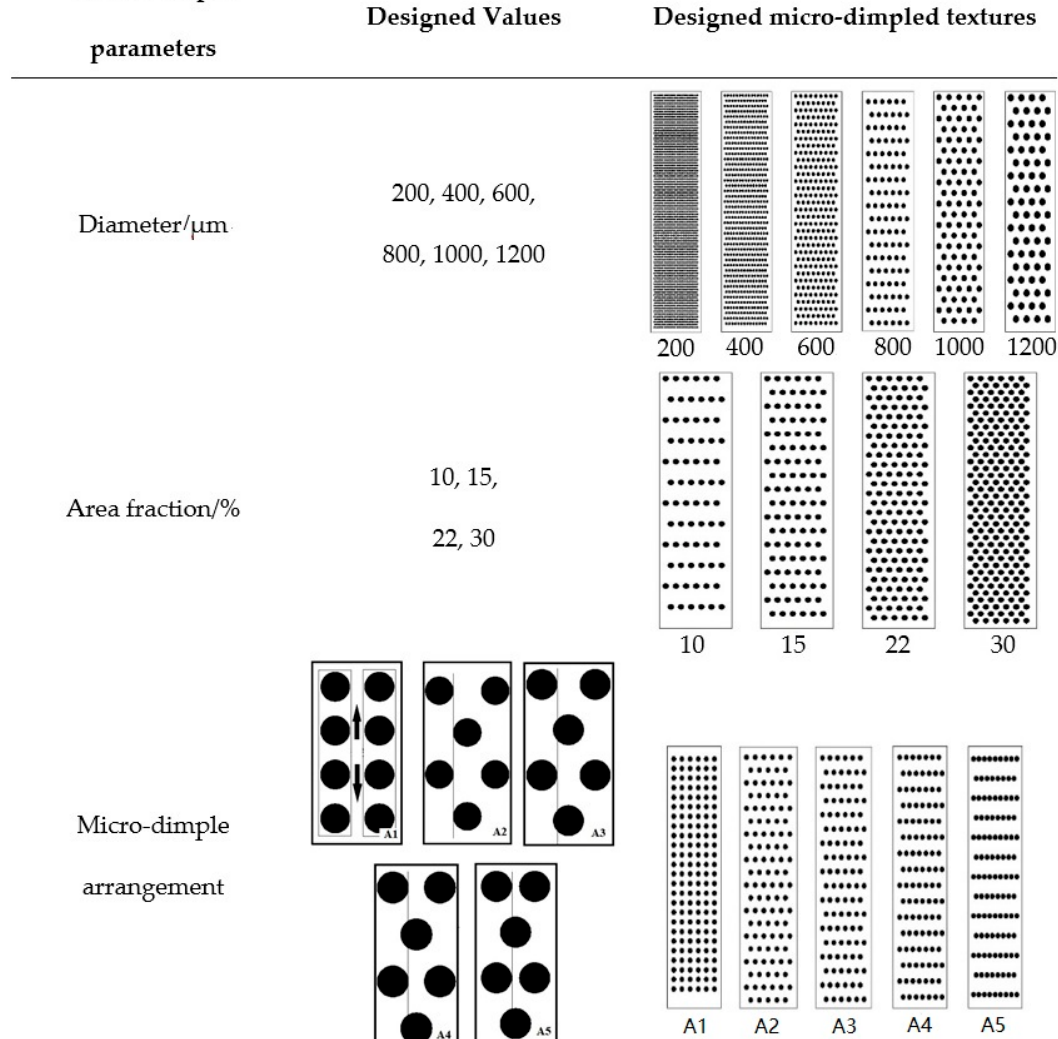
Figure 4. The designed parameters of micro-dimpled textures on the cylinder liner. Experimental conditions of the running-in and starved lubrication